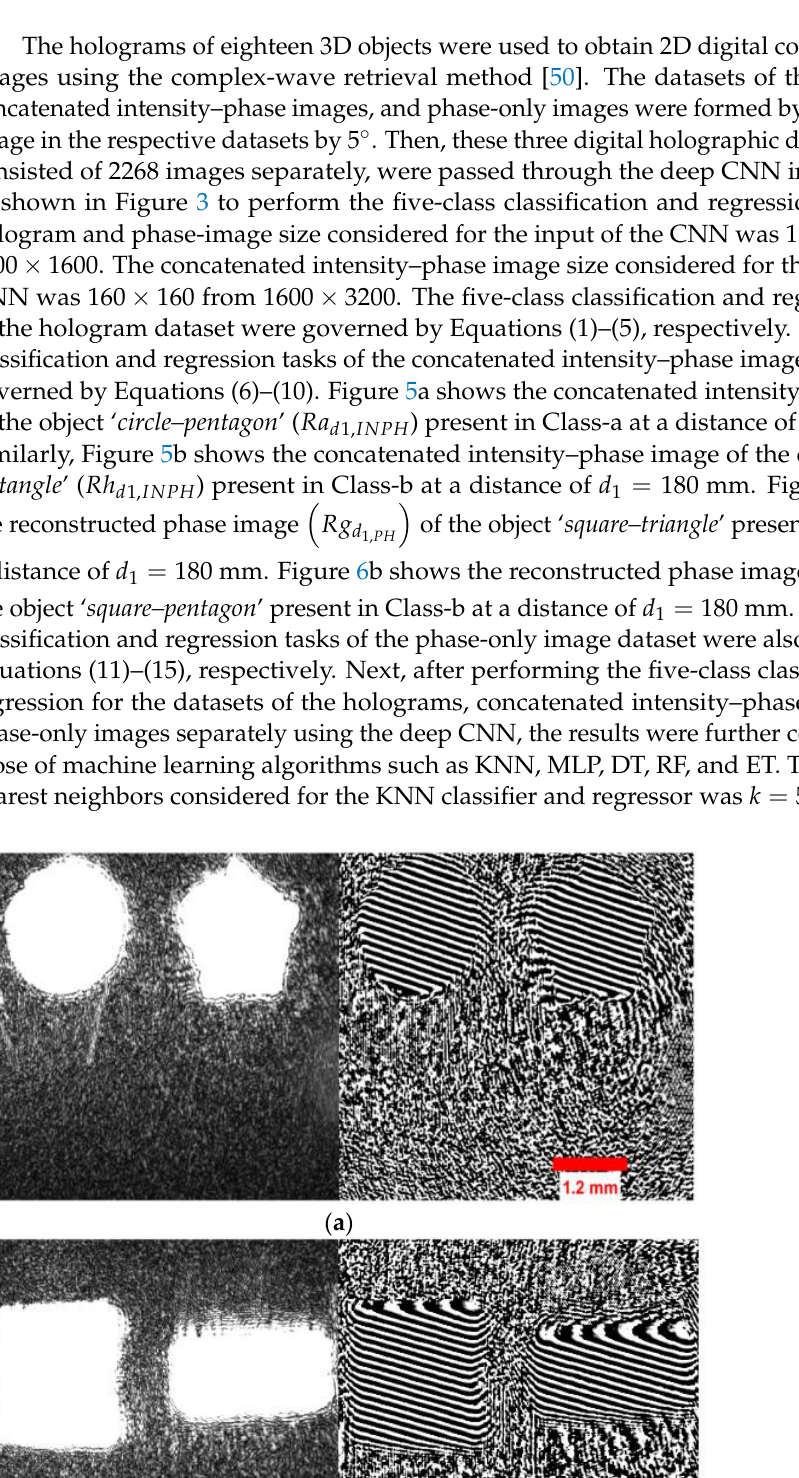
( b ) Figure 6. Reconstructed phase images at a distance of 𝑑 1 = 180𝑚𝑚 : ( a ) square – triangle ( 𝑅𝑔 𝑑 1,𝑃𝐻 ); ( b ) square – pentagon ( 𝑅𝑘 𝑑 1,𝑃𝐻 ). The MLP classifier and regressor, which consisted of a single hidden layer with ReLU as the activation function, were trained using an Adam optimizer with a learning rate and regularization rate (α) of 0.0003. The DT classifier and regressor was trained by setting 𝑚𝑎𝑥_𝑑𝑒𝑝𝑡ℎ = 2 . The RF classifier and regressor was trained by setting 𝑛_𝑒𝑠𝑡𝑖𝑚𝑎𝑡𝑜𝑟𝑠 = 10 , 𝑚𝑎𝑥_𝑑𝑒𝑝𝑡ℎ = 𝑛𝑜𝑛𝑒 , and 𝑚𝑖𝑛_𝑠𝑎𝑚𝑝𝑙𝑒𝑠_𝑠𝑝𝑙𝑖𝑡 = 2 . The ET classifier and regressor were also trained similarly to the RF classifier and regressor using the same parameters. For the five-class classification and regression tasks, all three digital holo- graphic datasets were separated into training, validation, and test sets with respective proportions of 75:15:10 . The training set consisted of 340 images in Class-a, Class-b, Class-c, and Class-d; and 341 images in Class-e. The validation set consisted of 68 images